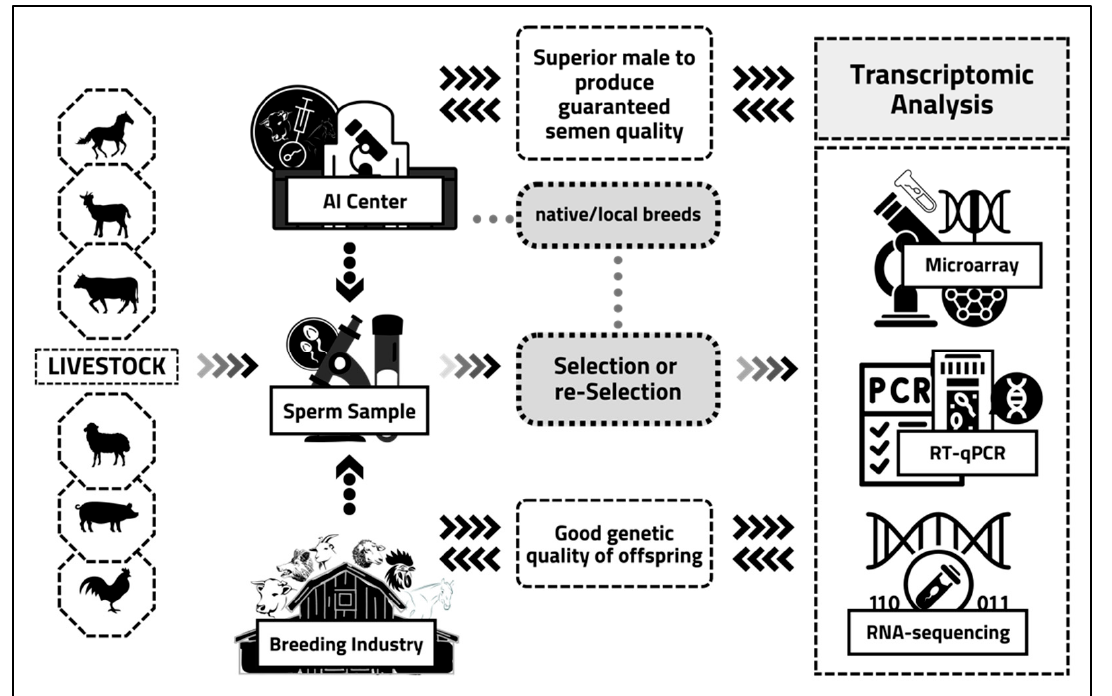
Figure 1. The concept of a superior male selection process is based on transcriptomic analysis in livestock. The primary sample in this new, insightful process comes from livestock sperm from the AI Center and the livestock-breeding industry. In addition, this concept also includes native/local breeds owned by several countries. Sperm samples from imported or native/local breeds are collected and used as primary specimens for the selection or re-selection process. The intended selection is for male candidates who can become superior males, while the intended re-selection is for eliminating males that were previously “considered” superior. Still, the results of insemination in the field proved to have low fertility/sub-fertility. This new selection and the re-selection process is based on transcriptomic analysis using various analytical techniques, such as microarrays, quantitative real-time PCR, and RNA sequencing. Hopefully, this transcriptomic analysis can find potential sperm transcriptomes that can be used as fertility markers to predict male fertility rates. It will undoubtedly impact the availability of superior males, whose semen quality is guaranteed and can contribute significantly to the AI Center. In addition, this new concept of male selection through a transcriptomic approach is expected to increase the genetic quality of the offspring. It will undoubtedly be very beneficial for livestock-breeding industries.